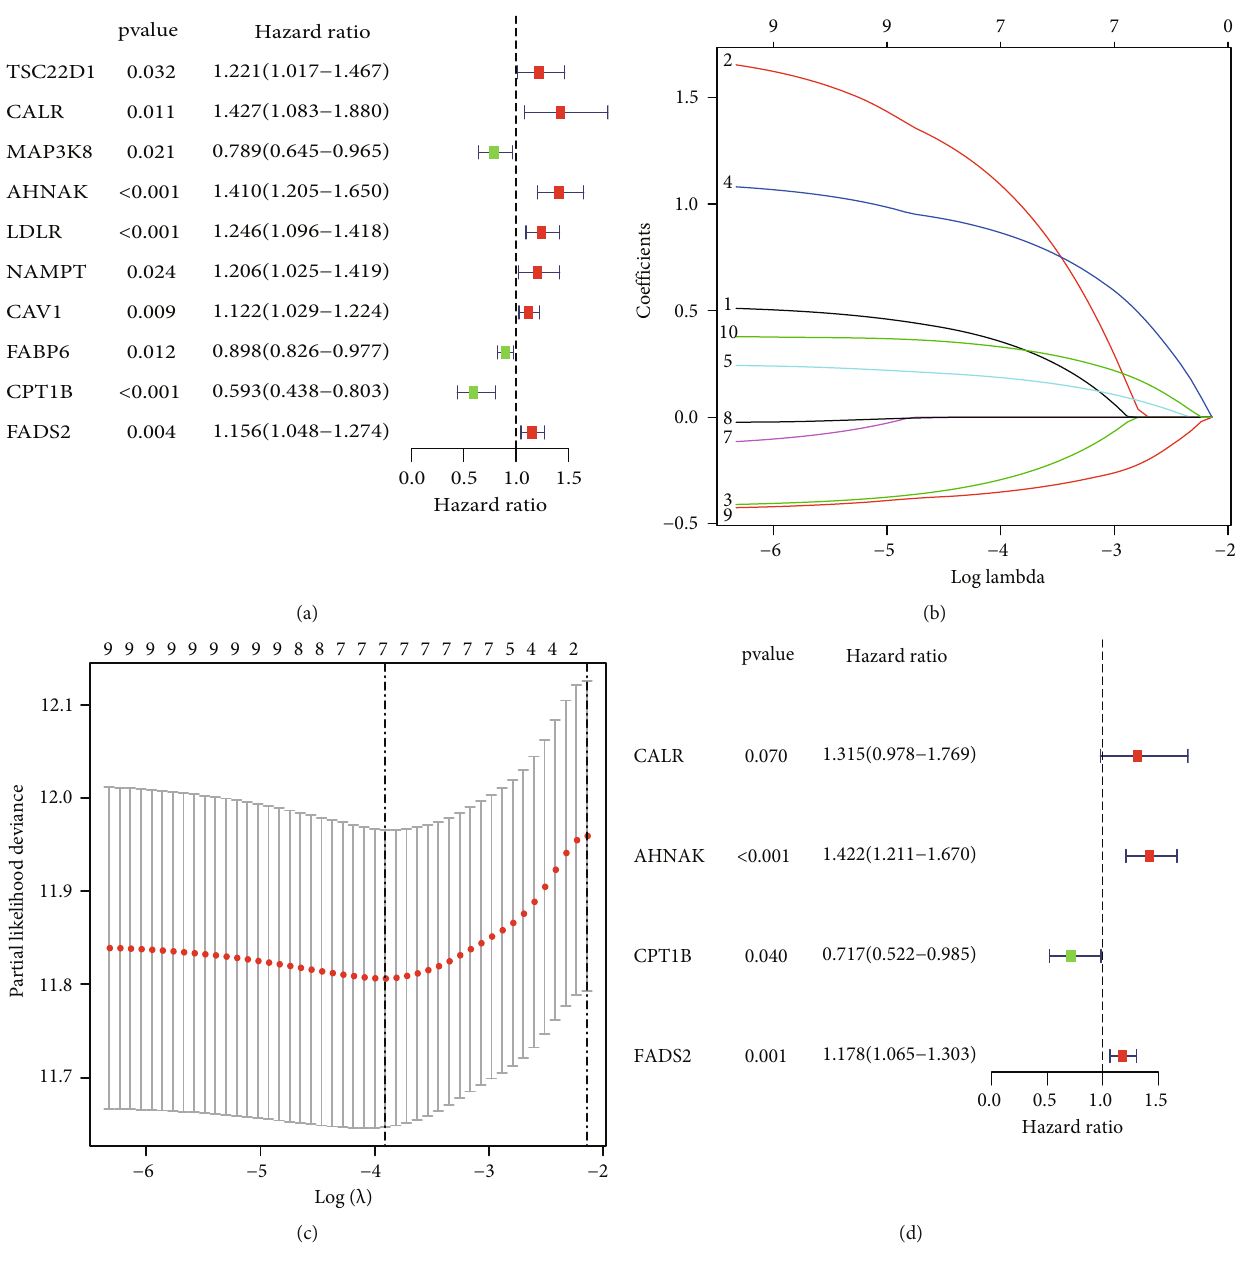
Figure 3: Identi fi cation of DEPPARGs correlated with prognosis in the TCGA dataset. (a) Identi fi cation of the prognostic DEPPARGs by univariate Cox regression analysis; (b) the coe ffi cient pro fi le of 9 prognostic genes by LASSO regression analysis; (c) tenfold cross-validation for tuning parameter selection in the LASSO analysis; (d) identi fi cation of 4 prognostic DEPPARGs by multivariate Cox regression